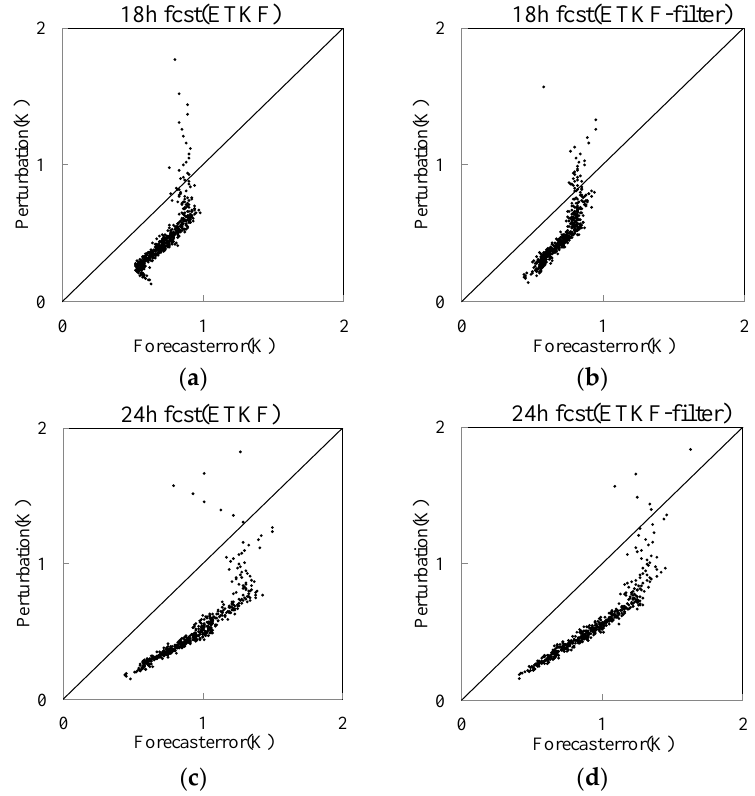
Figure 8. Scatter plot of the relationship between ensemble perturbation and forecast error for a 500 hPa temperature. ( a ) 18 h forecast for ETKF, ( b ) 18 h forecast for ETKF-SS, ( c ) 24 h forecast for ETKF, ( d ) 24 h forecast for ETKF-SS.